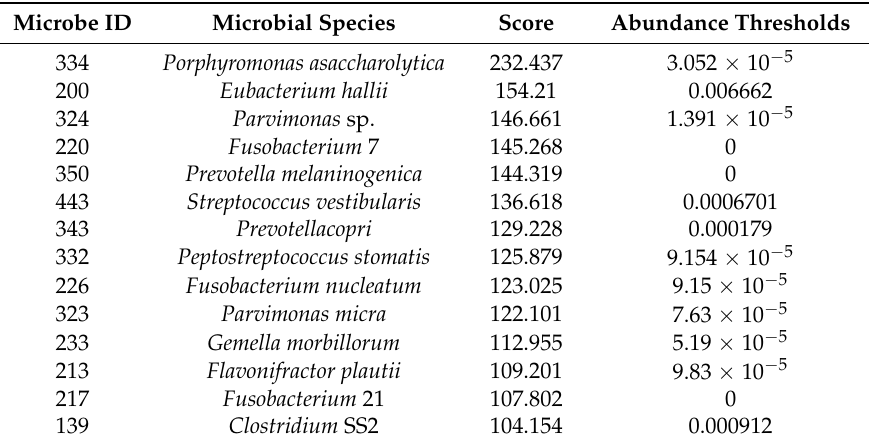
Table 4. Microbial species with high scores and abundance